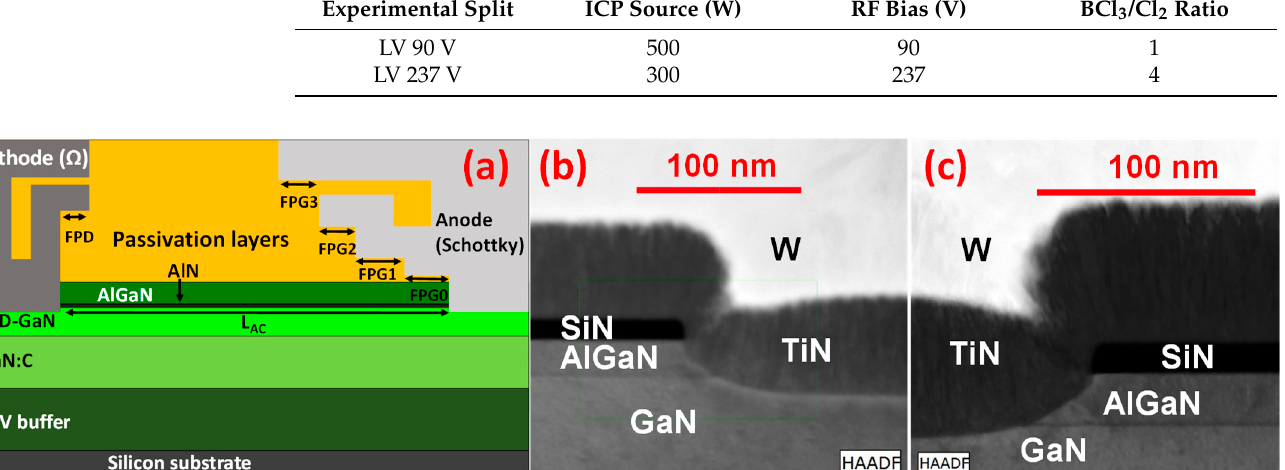
Table 1. ICP-RIE etching split table.